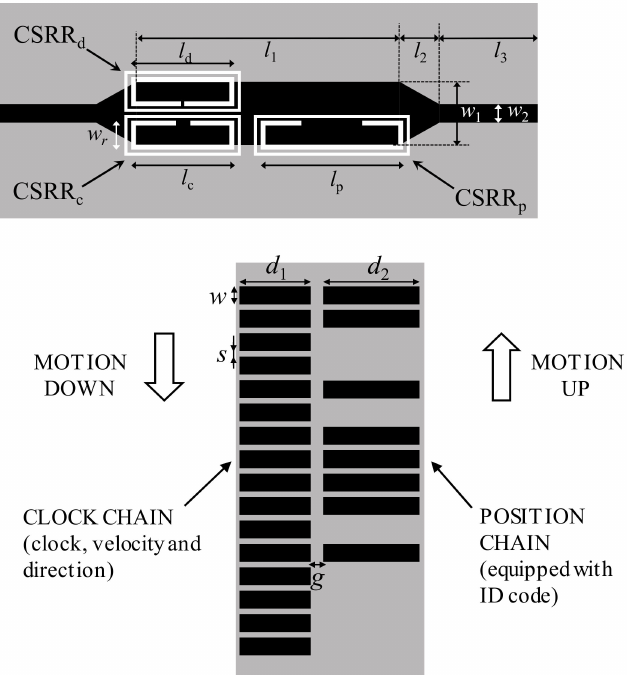
Figure 25. Layout of the reader and encoder of the absolute encoder system based on metallic patches, with motion direction detection capability. The total area of the encoder is 30 × 70 mm 2 , with the following metallic patch dimensions: d 1 = 11.5 mm; d 2 = 15.9 mm, w = 3 mm, s = 1 mm and g = 1.9 mm. Reader dimensions are: l 1 = 26.6 mm; l 2 = 3.8 mm, l 3 = 10 mm, w 1 = 6.4 mm, w 2 = 1.9 mm, l c = l d = 10.5 mm; l p = 14.5 mm, w r = 2.9 mm. CSRR slots width is c = 0.5 mm, and ring splits are s d = 0.4 mm, s c = 1.6 mm h = 0.81 mm, dielectric constant ε r = 3.38, and loss factor tan δ = 0.0022. The reader substrate is